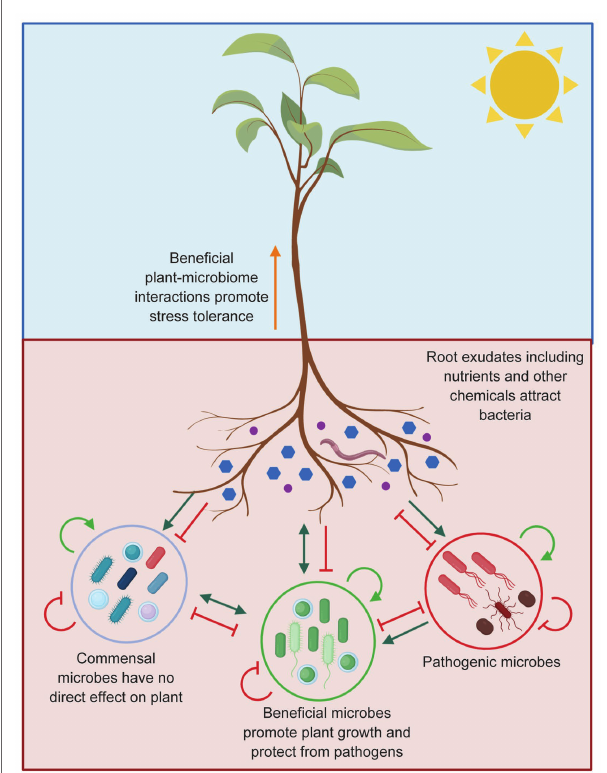
FIGURE 5 | Plant-microbe interactions in the rhizosphere. Plants can influence the composition of microbiome surrounding plant roots through exudation of compounds that stimulate (green arrows) or inhibit (red blocked arrows) microbes. A wide range of pathogens living in the soil can also affect plant health. Being able to attract the beneficial microbes will limit the success of the pathogenic microbes due to resource competition or by enhancing the plant immune system. The commensal microbes do not affect the plant or the pathogen directly. Microbiome-plant interactions are presented as described by Berendsen et al. (2012).